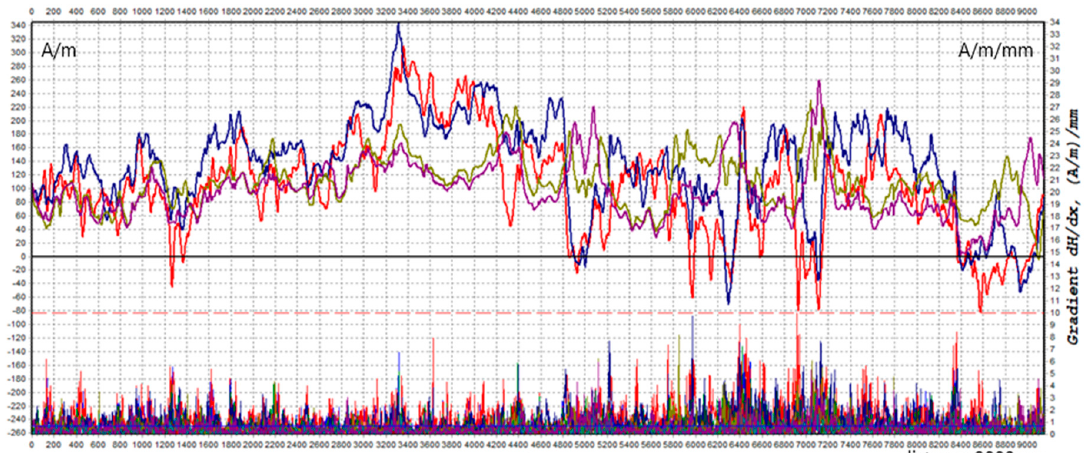
Figure 3. Distribution of tangential component Hpx along L3.